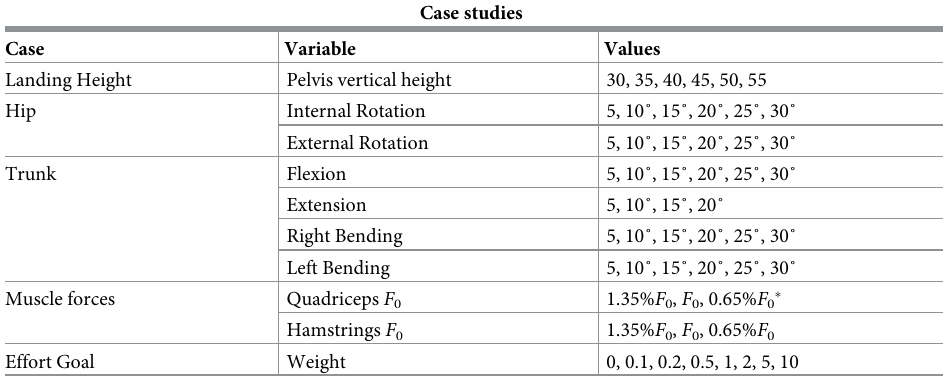
Table 1. Overview of the investigated scenarios to identify ACL injury risk factors during single-leg